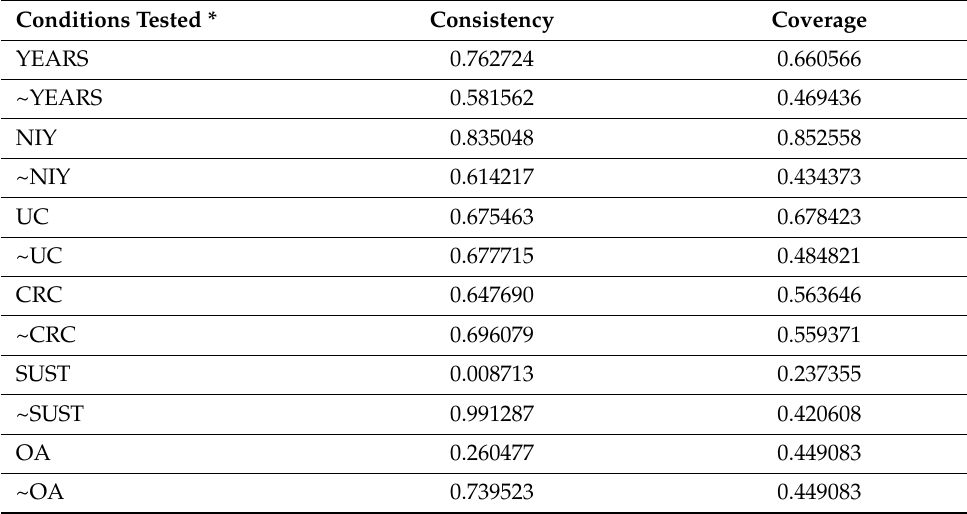
Table 4. Analysis of Necessary Conditions. Outcome variable: